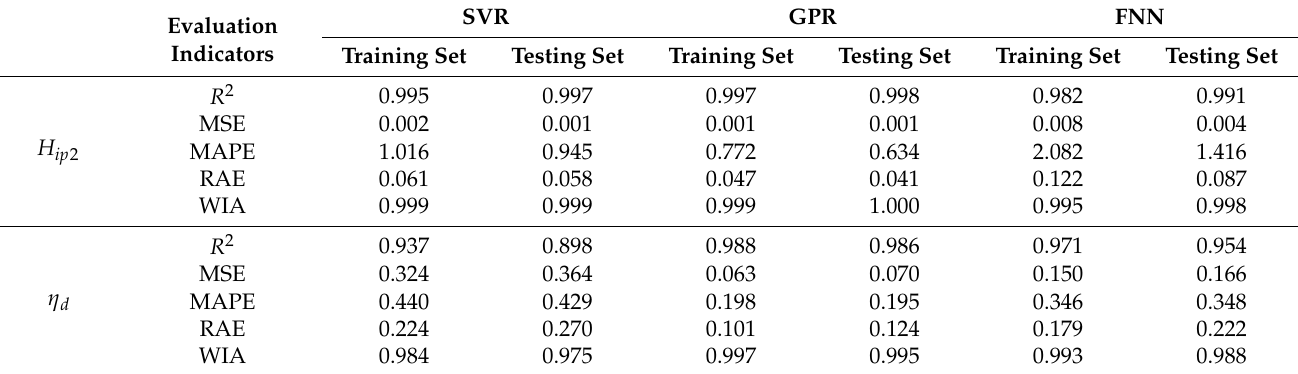
Table 4. Comparison of the prediction results of the three